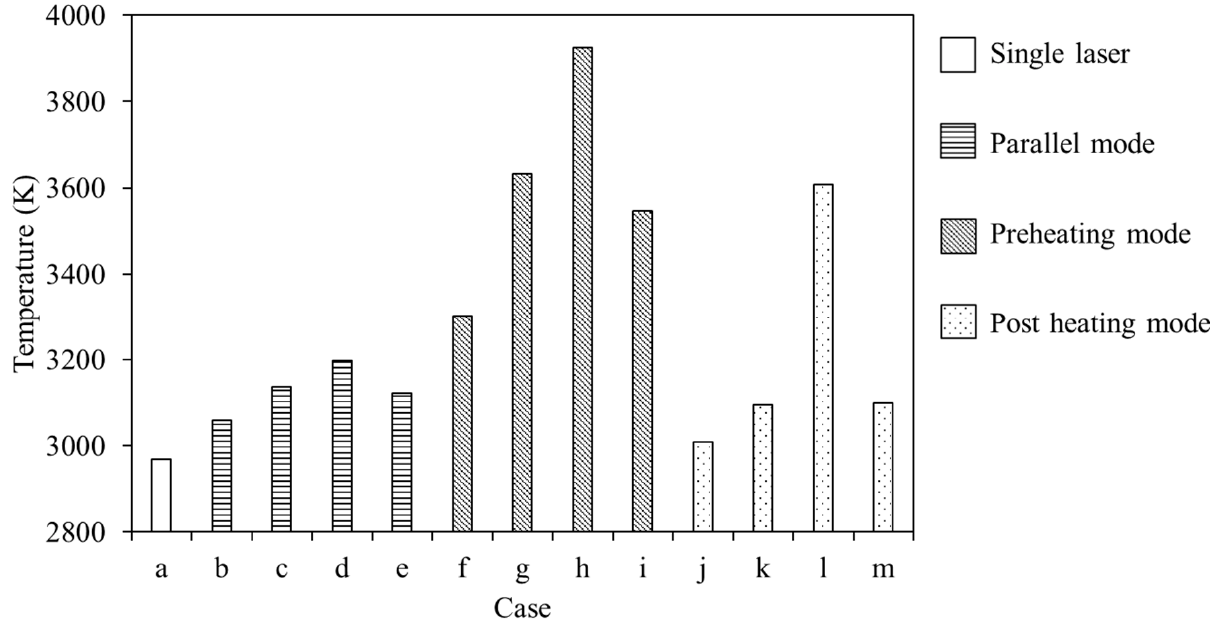
Figure 6. Peak temperature for different scanning modes and process parameters: ( a ) single laser beam; ( b )–( e ) parallel model; ( f )–( i ) preheating mode; ( j )–( m ) post ‐ heating mode.